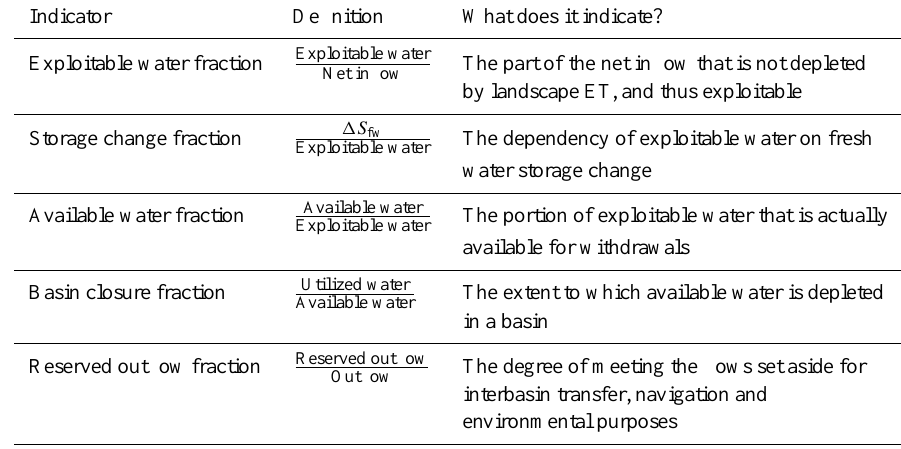
Table 2. Key performance indicators of the resource base